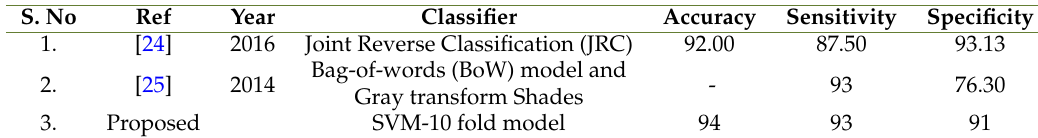
Table 3. Comparison of proposed SVM-10 fold model with existing methods